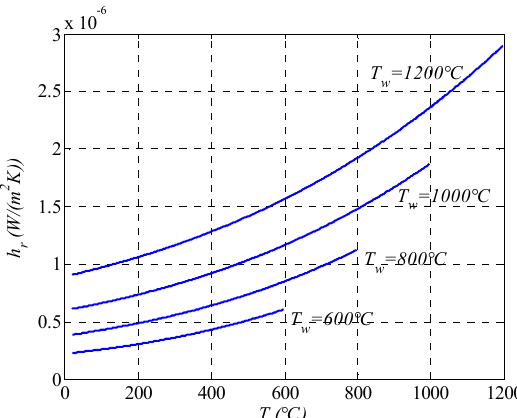
Figure 6. Relationship between surface heat transfer coefficient and temperature.